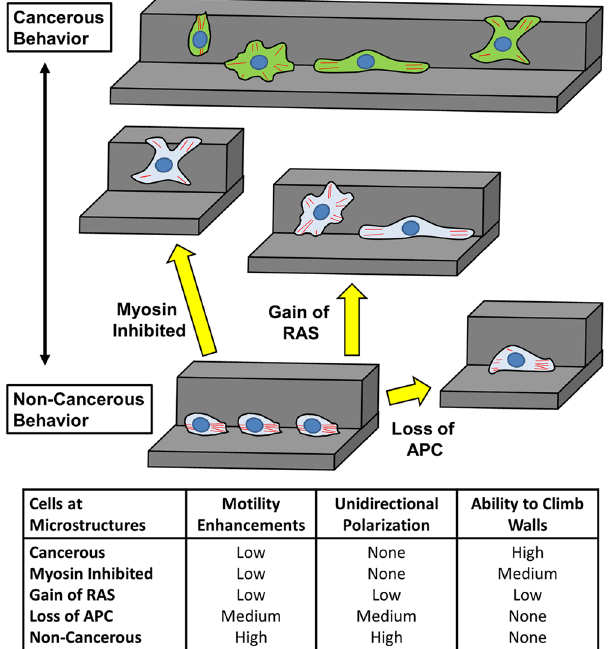
Figure 5. Schematic summary of the cell-geometry interactions for various cancerous and non-cancerous epithelial